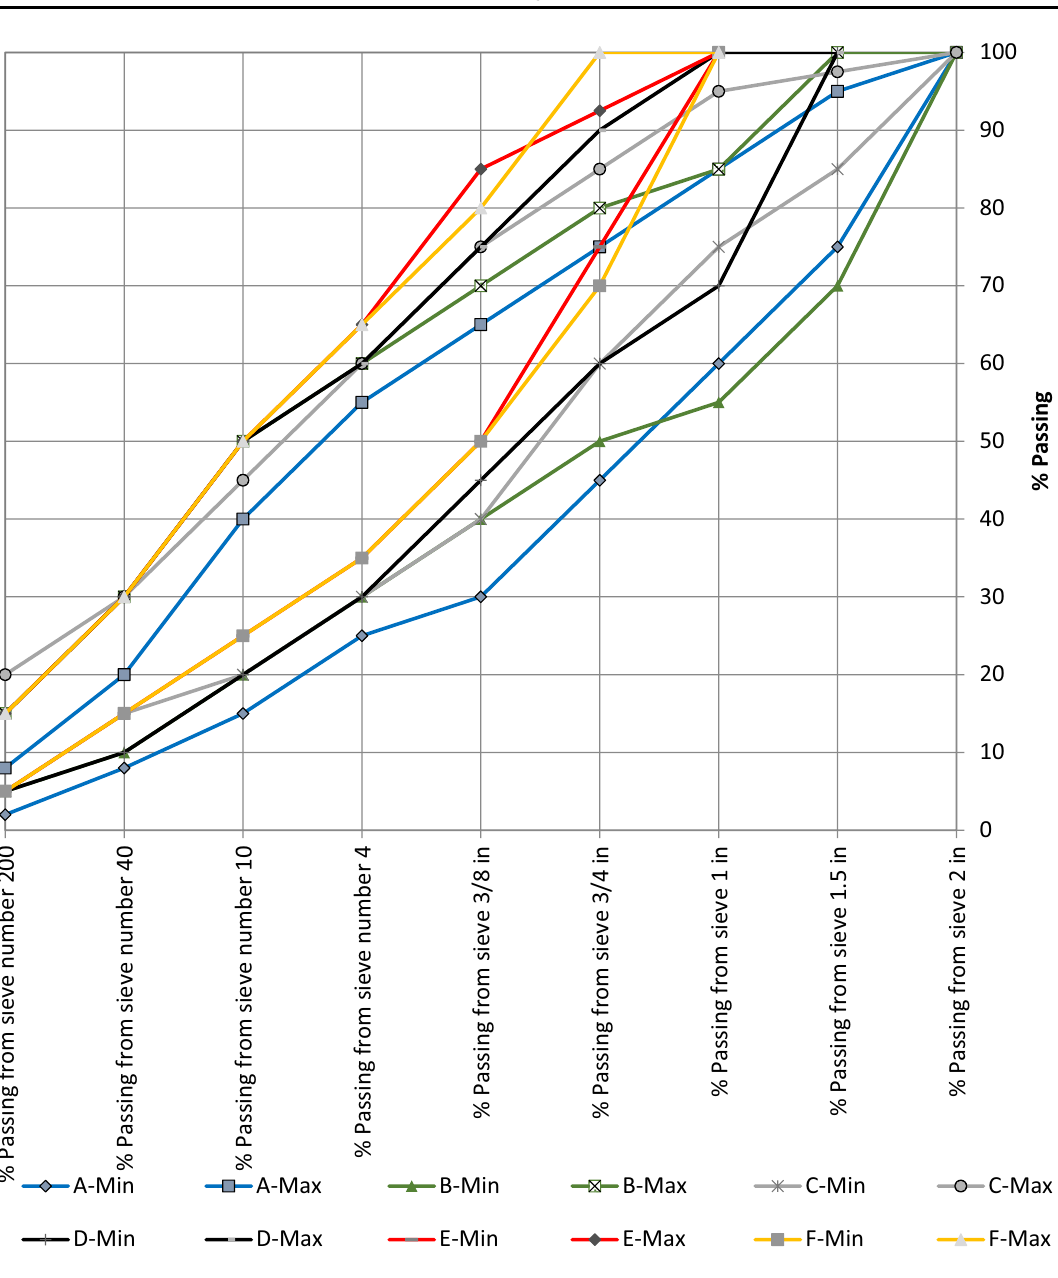
Fig. 3 Aggregate base gradations used in